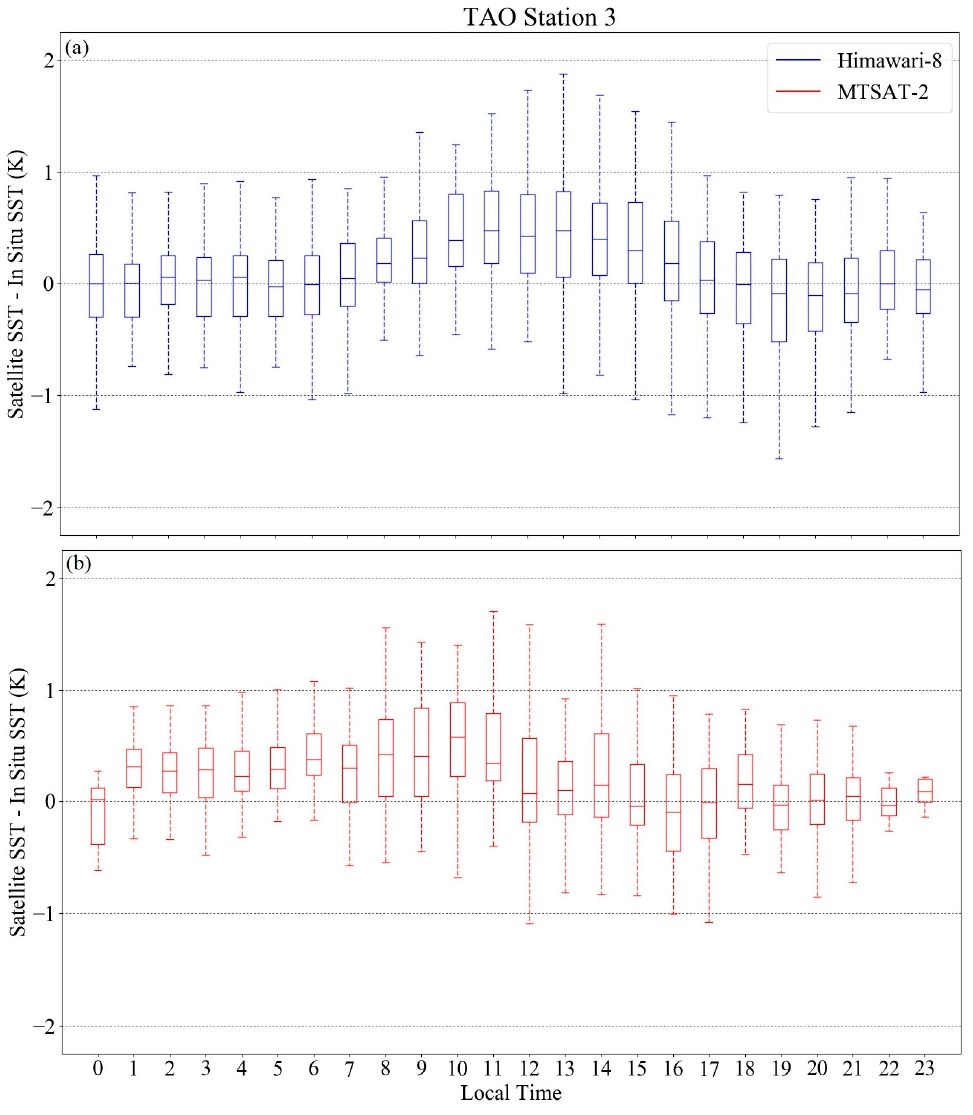
Figure 7. Box plots of the hourly differences between the satellite-derived SSTs and the subsurface temperatures measured at TAO Station 3 at 2°N, 137°E. Differences of SSTs from Hiawari-8 are shown in blue in ( a ), and from MTSAT-2 in red in ( b ). Outliers are not plotted. The data are of best quality level from 1 August 2015–31 October 2015.